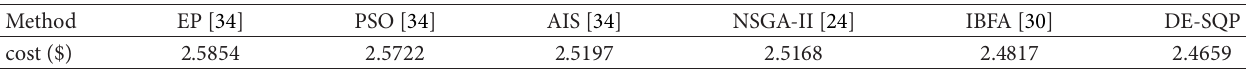
Table 2: Comparison results of 10-thermal-unit system (cost ×10 6 $) for the DED problem.